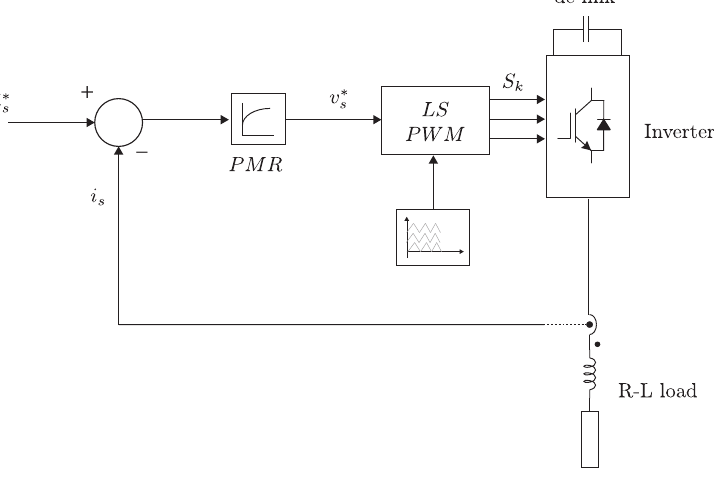
Figure 8. Block diagram of the single-phase current control